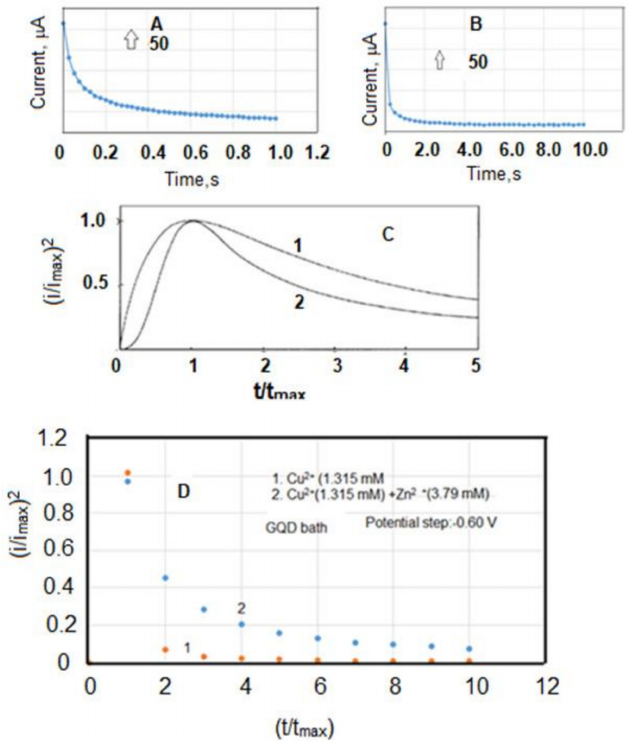
Figure 2. ( A ) Potential-step electrolysis at − 0.60 V in a 1.31 mm cupric sulfate solution containing 1 mL GQD. ( B ) Medium: 1.31 mm Cu 2+ + 3.79 mm Zn 2+ + 1 mL GQD. ( C ) Theoretically modelled behaviors of (1) instantaneous nucleation and (2) progressive nucleation. ( D ) Nucleation model for (1) copper deposition and (2) copper deposition in the GQD bath containing zinc